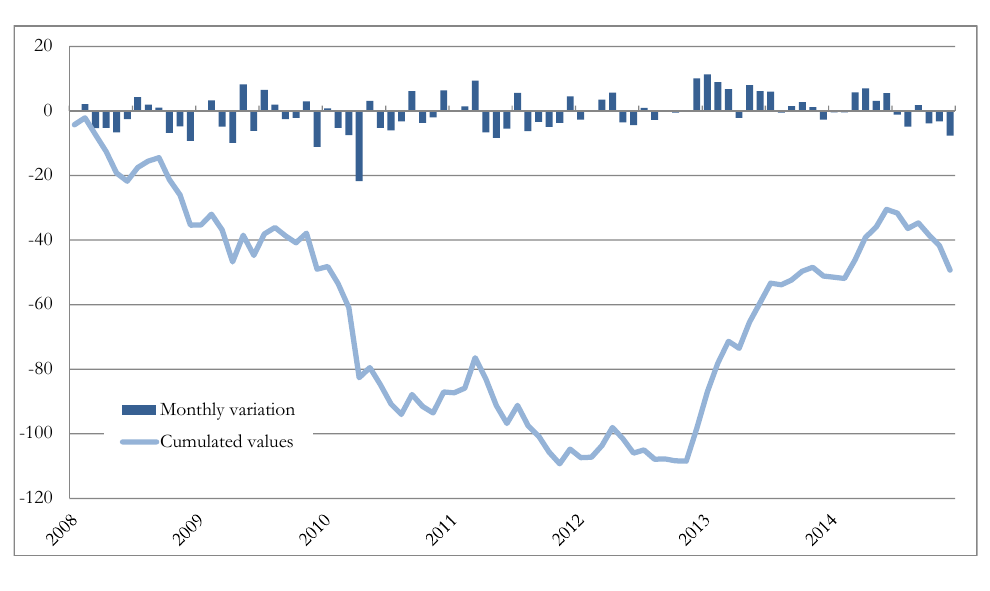
Figure 2. TARGET2 balances towards the Eurosystem, Greece (Euro billion, monthly, end of the period). Source: Elaboration on the “Institute of Empirical Economic Research—Osnabrück University” dataset (accessed on 25 June 2015, http://www.eurocrisis monitor.com/).